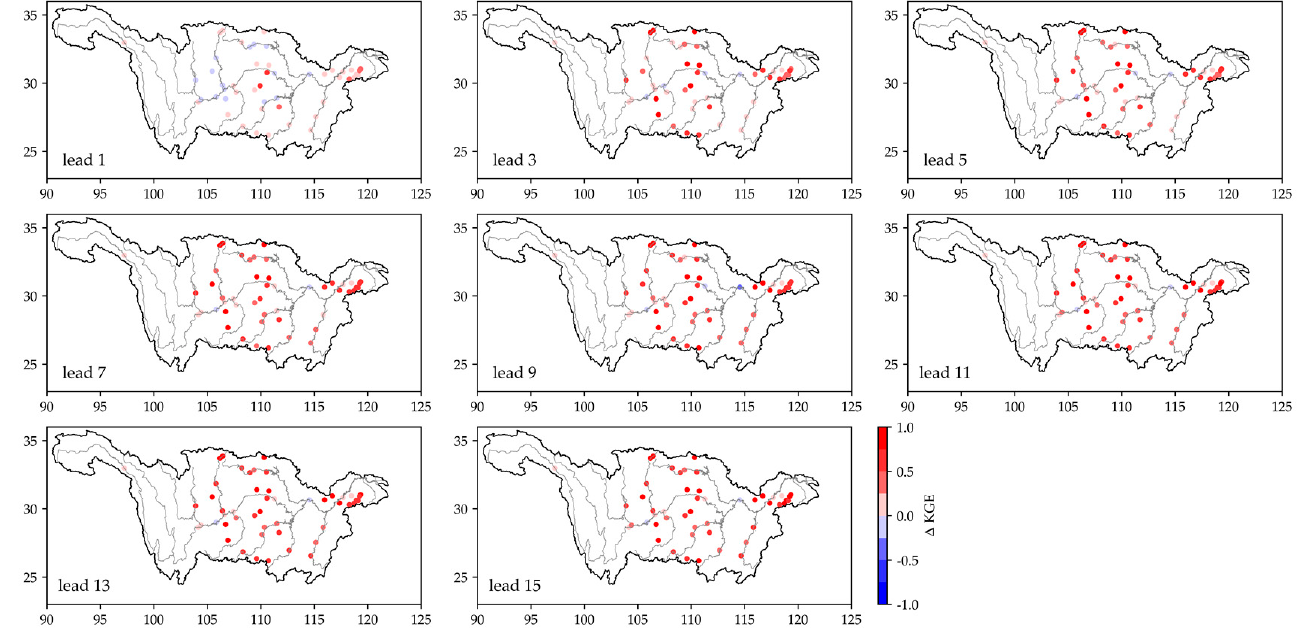
Figure 10. Spatial distributions of the KGE difference ( ∆ KGE) between the daily streamflow forecasts by the cascade LSTM with prefect precipitation and those by default LSTM.